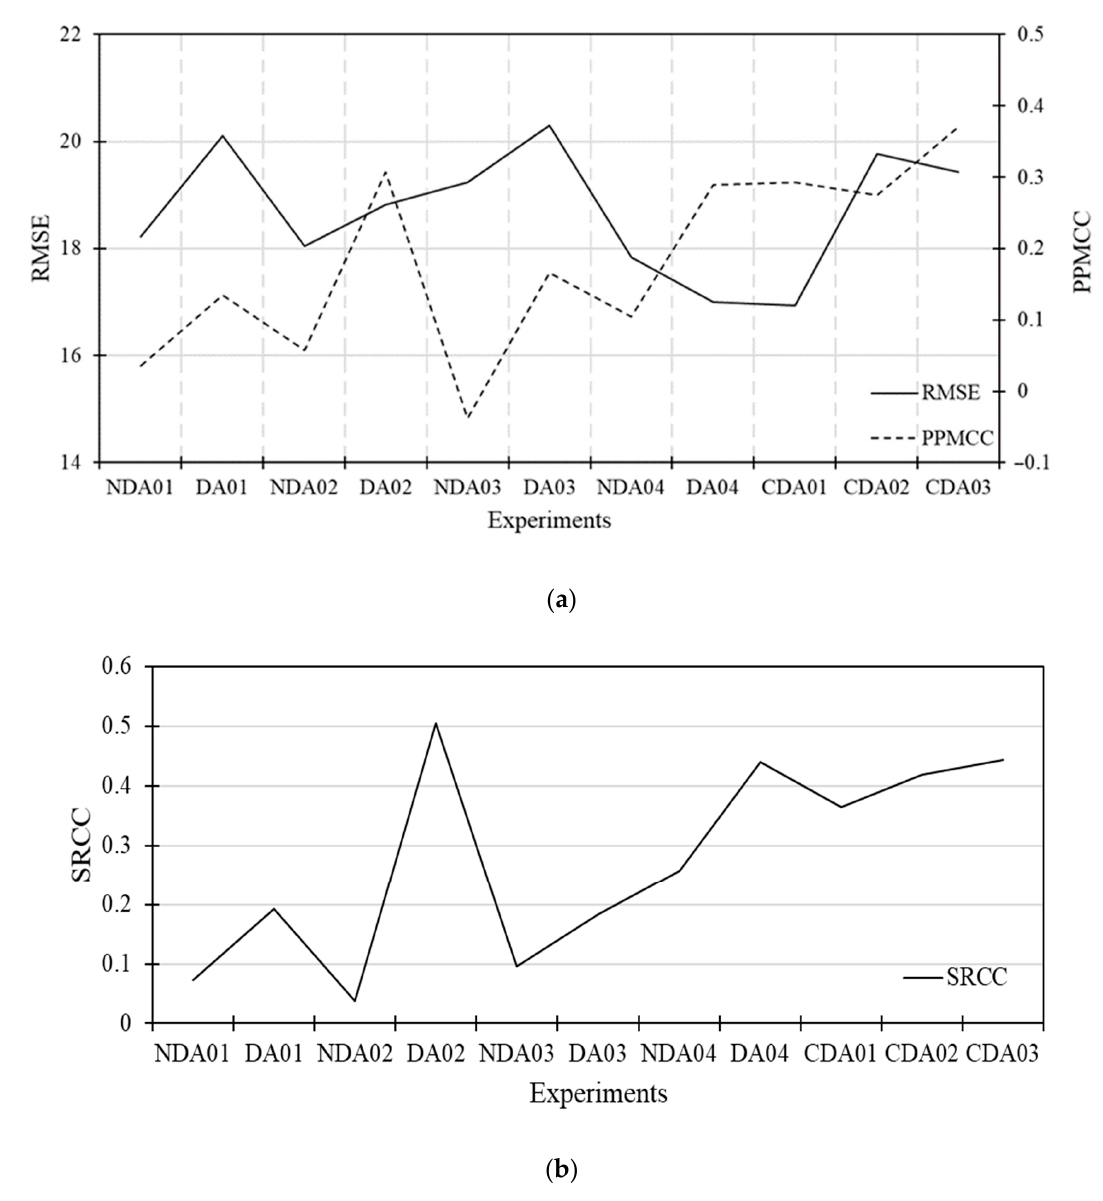
Figure 15. ( a ) RMSE (black line) and PPMCC (black dashed line) and ( b ) SRCC of C1, C2 and C3 experiments for the 6-h accumulated precipitation (mm) against the corresponding AWS observations during 0500–1100 UTC (1300–1900 LST).